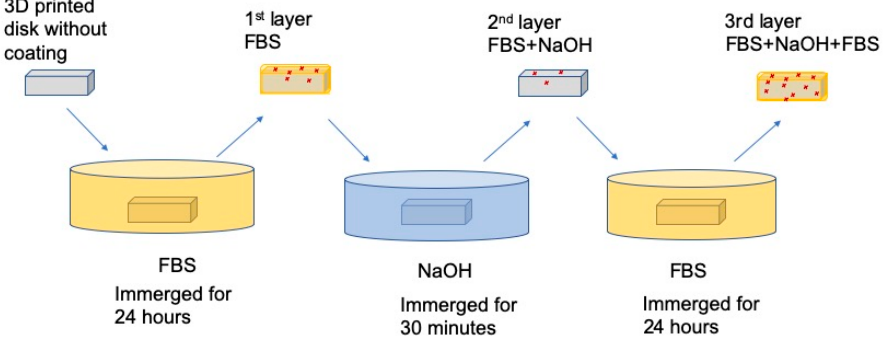
Figure 3. The process of applying the three-layered coating onto 3D printed squares.